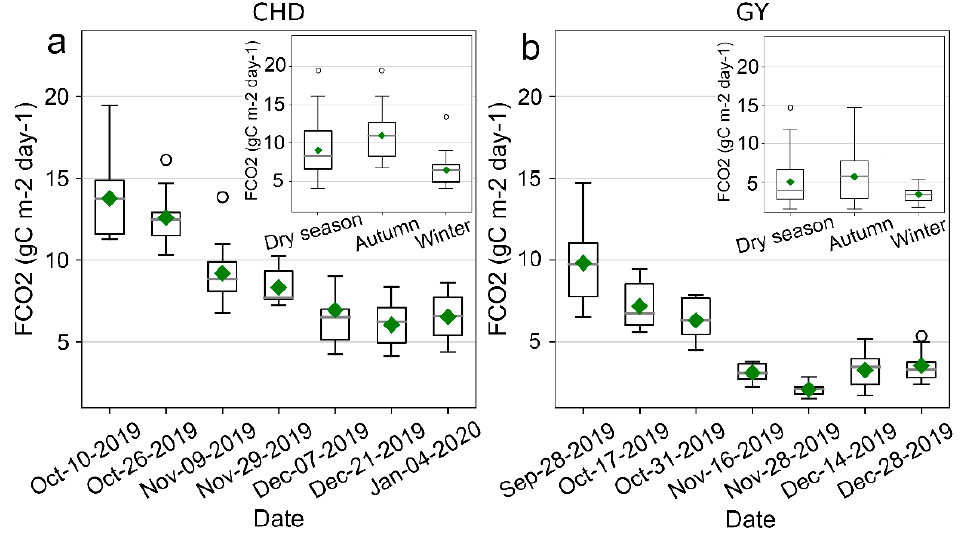
Figure 2. Temporal variations of the FCO 2 in ( a ) CHD ( n = 35) and ( b ) GY ( n = 35) area. The embedded figures are based on summarized values of the FCO 2 for the whole dry season, autumn, and winter, respectively. The green quadrilateral represents the average, the gray line in the boxplot is the median, and the black circles are outliers.